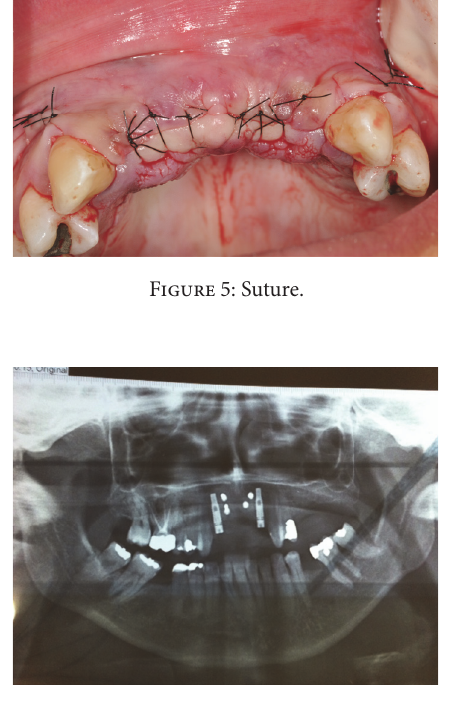
Figure 6: Panoramic radiograph after 10 months postoperatively.